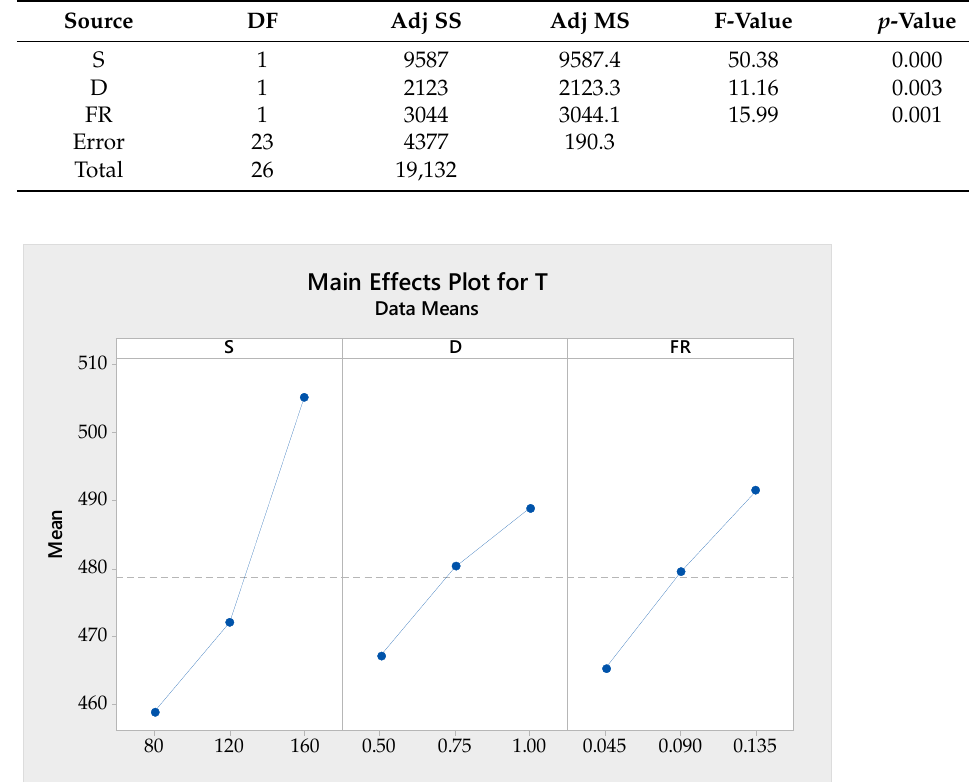
Figure 15. Main effect plots for T using wiper cutting edge.